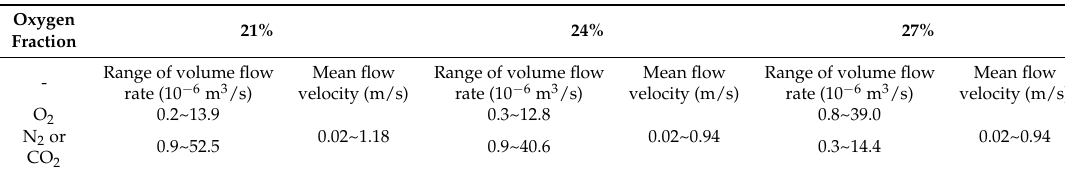
Table 1. Range of flow conditions tested.